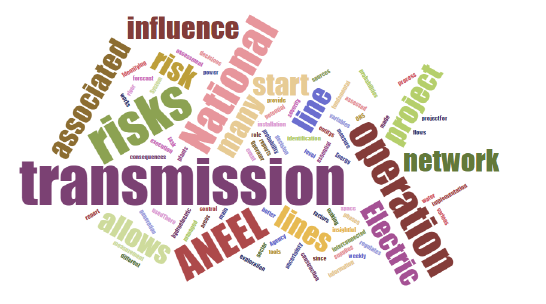
Figure 3. The most relevant keywords identified in the ANEEL reports.